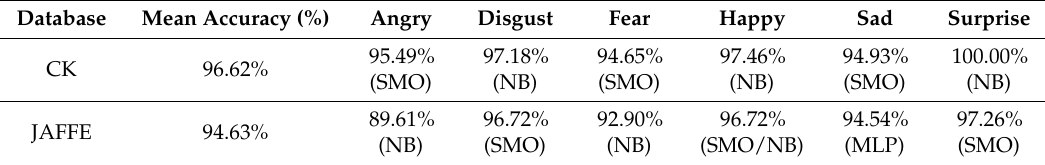
Table 10. The recognition results of the best performed classifier on CK and JAFFE.